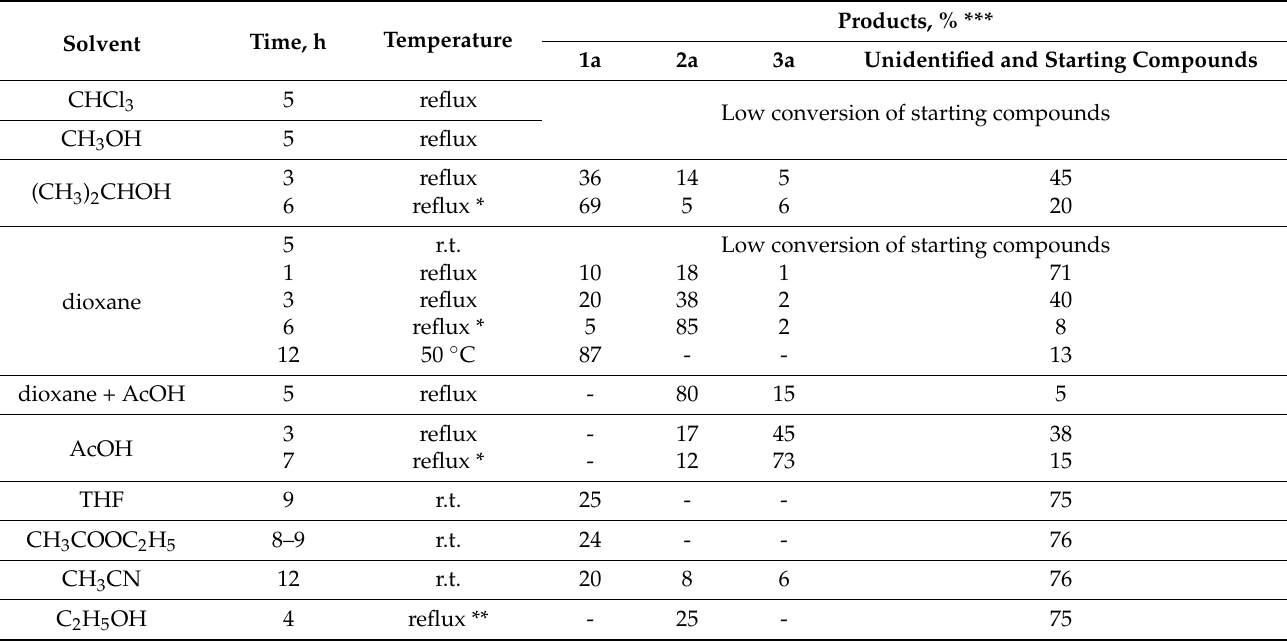
Table 1. Conditions for the reaction of N-arylmaleimides with thioacetamide and the product com- position.